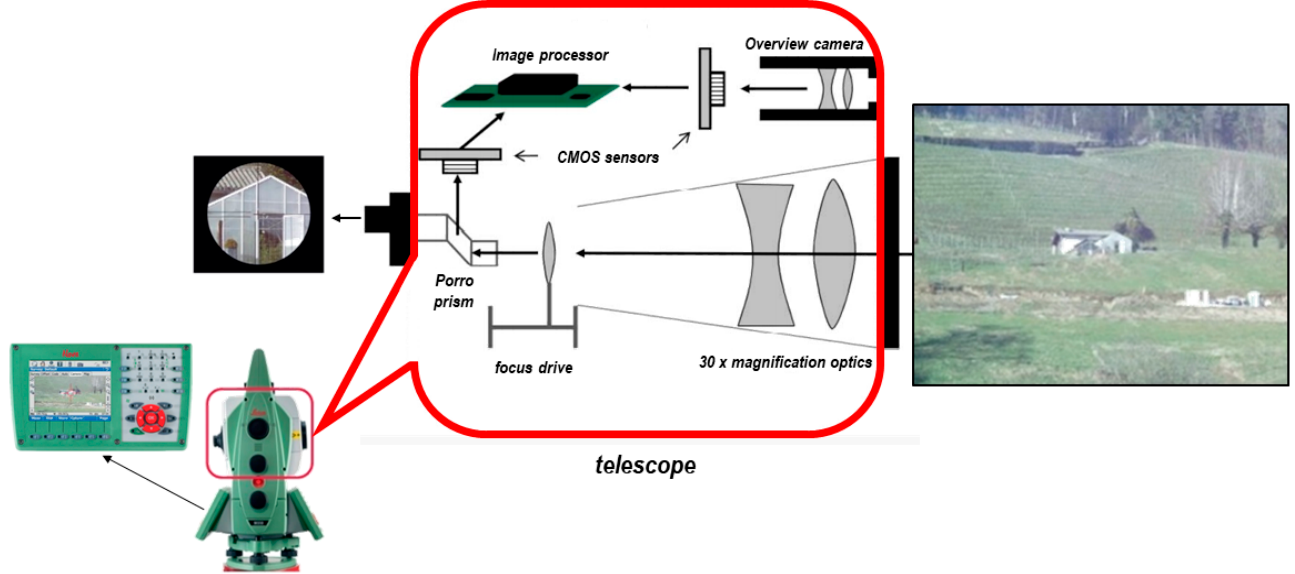
Figure 9. Leica MS50 schematic cross-sectional view of the telescope with image sensoros and processor integration, as well as motorization for autofocus; scheme modifed for this study from [57].